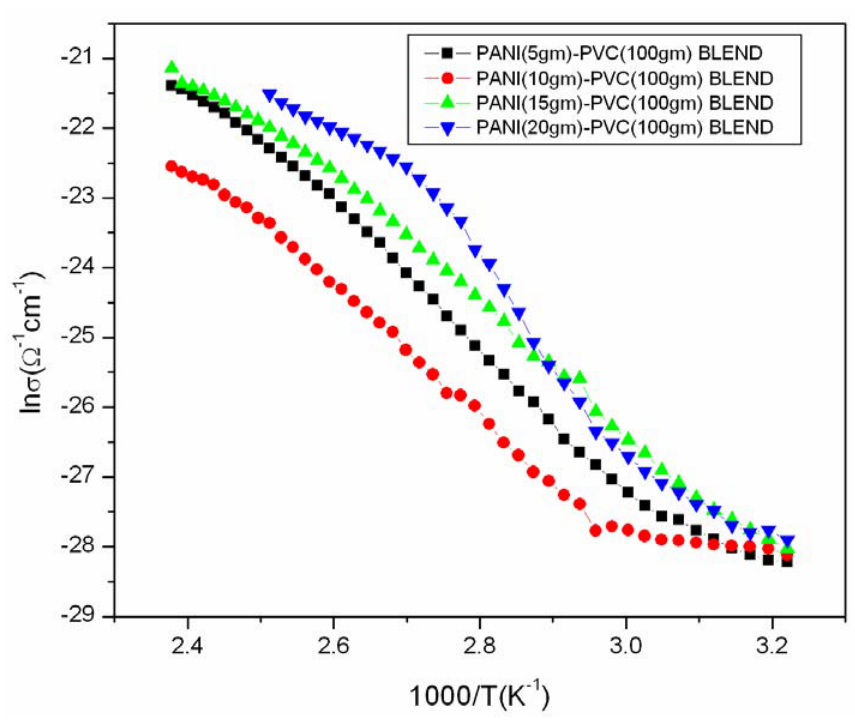
Fig. 6 Variation of dc conductivity with 1000/T for PANI doped with 20 % sulfamic acid in PANI-PVC blends.